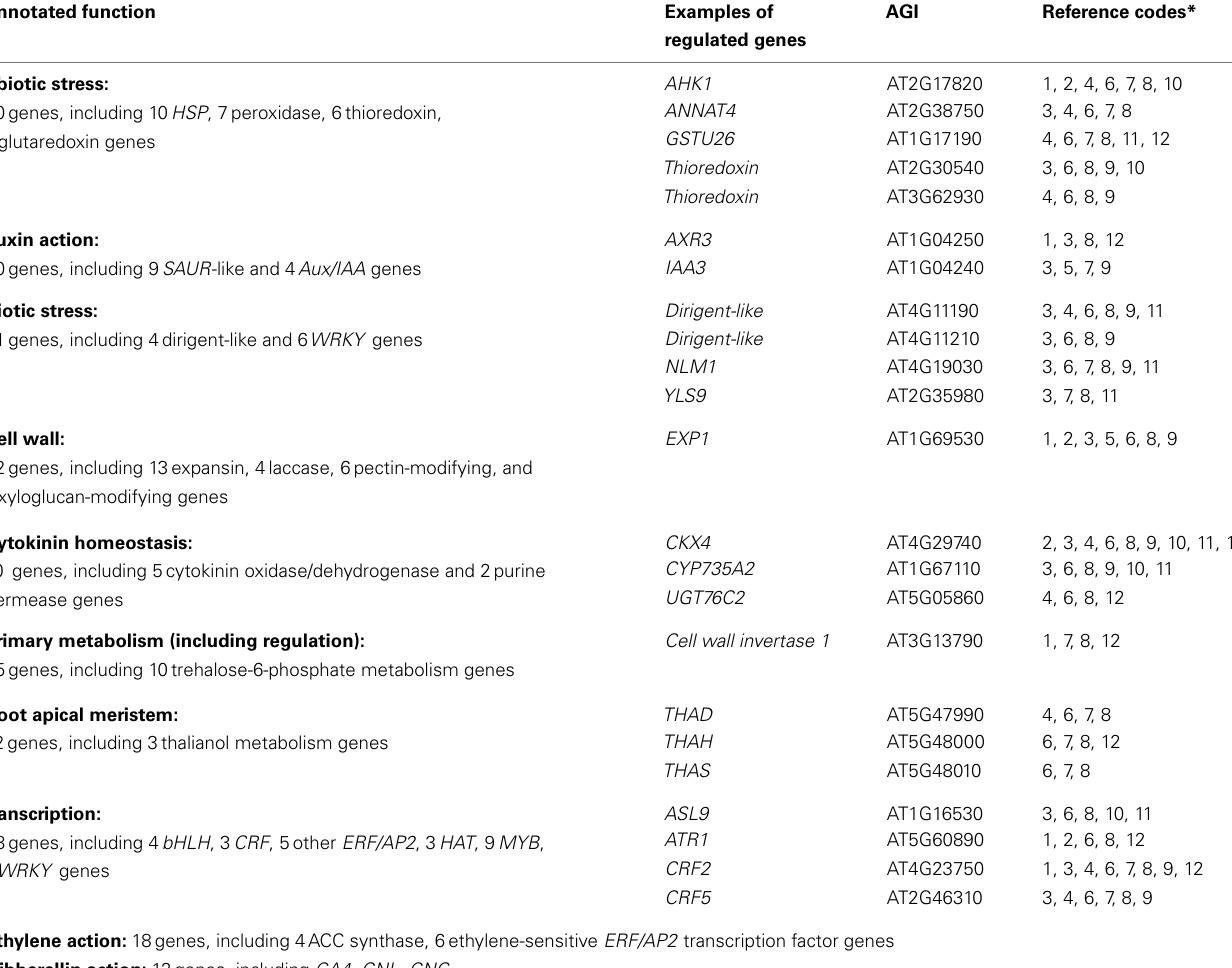
Table 4 | Selection of developmental and physiological processes in which cytokinin-regulated genes